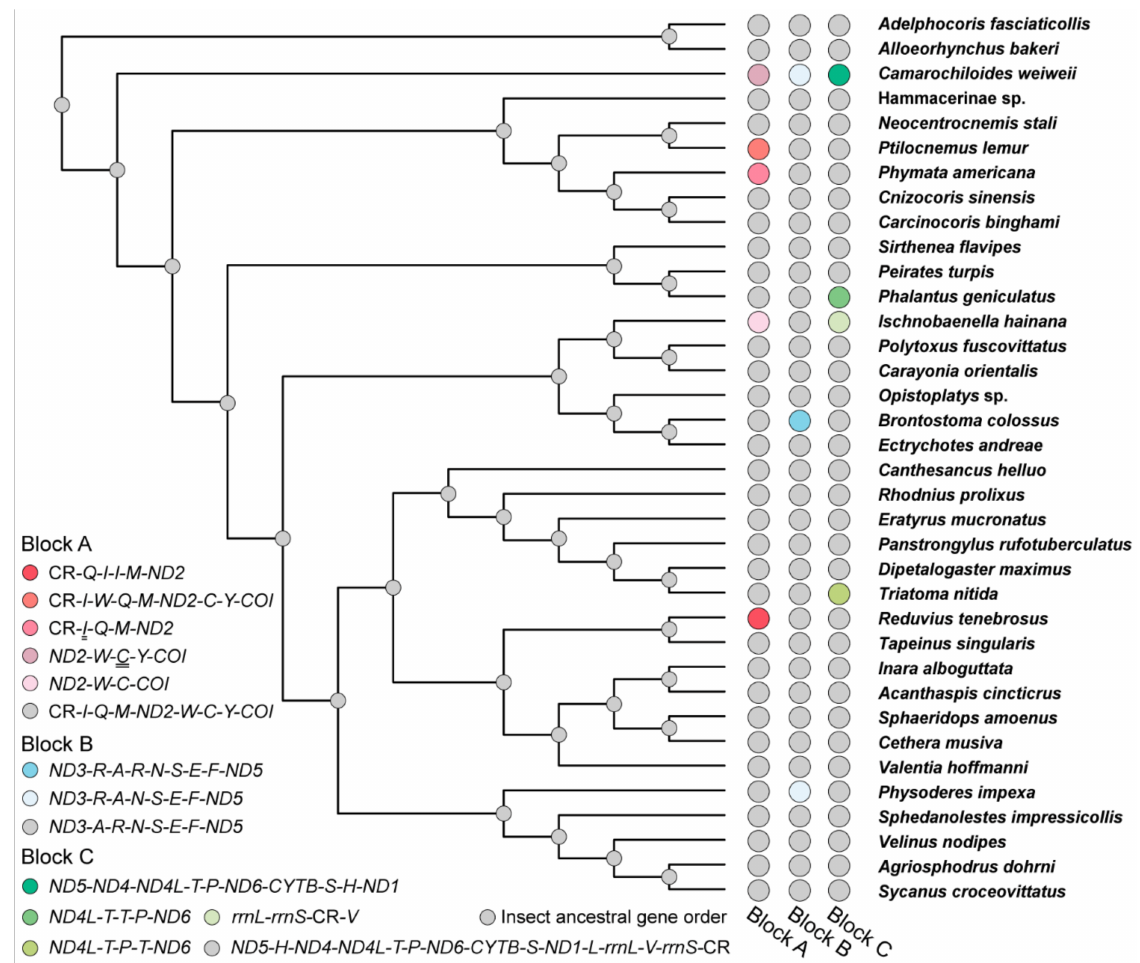
Figure 3. The ancestral state reconstruction of gene order for reduviid mitogenomes. The grey balls at nodes indicate all three gene blocks with the insect ancestral gene order. Genes marked with double underlines are absent in correspond- ing